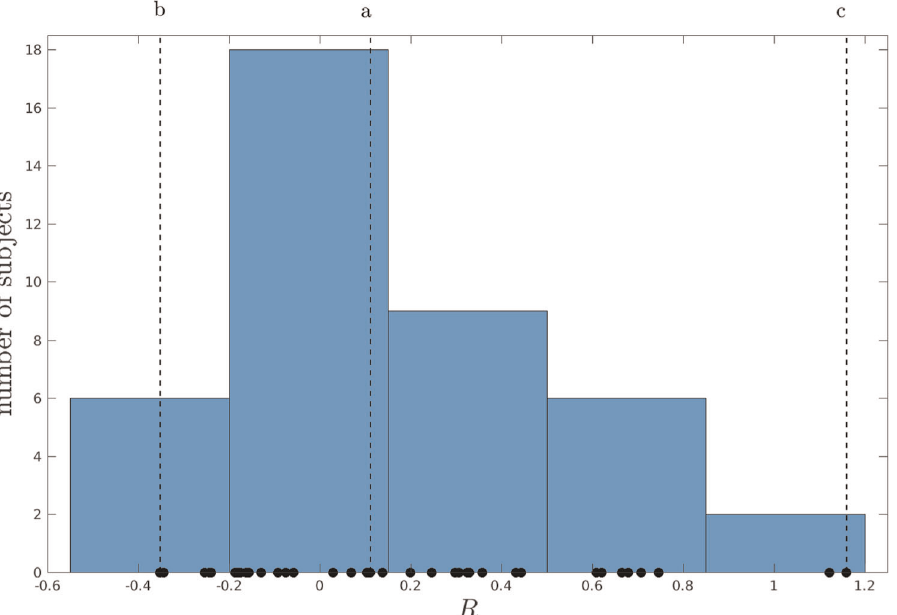
Fig. 3 Distribution of the indicator R = σ e ( A 2 − A 1 )/ u m over test subjects. The number of subjects per bin is on the vertical axis, while individual data are indicated with dots on the horixontal axis. The dashed lines labeled a, b, and c correspond to the inlays in Fig.